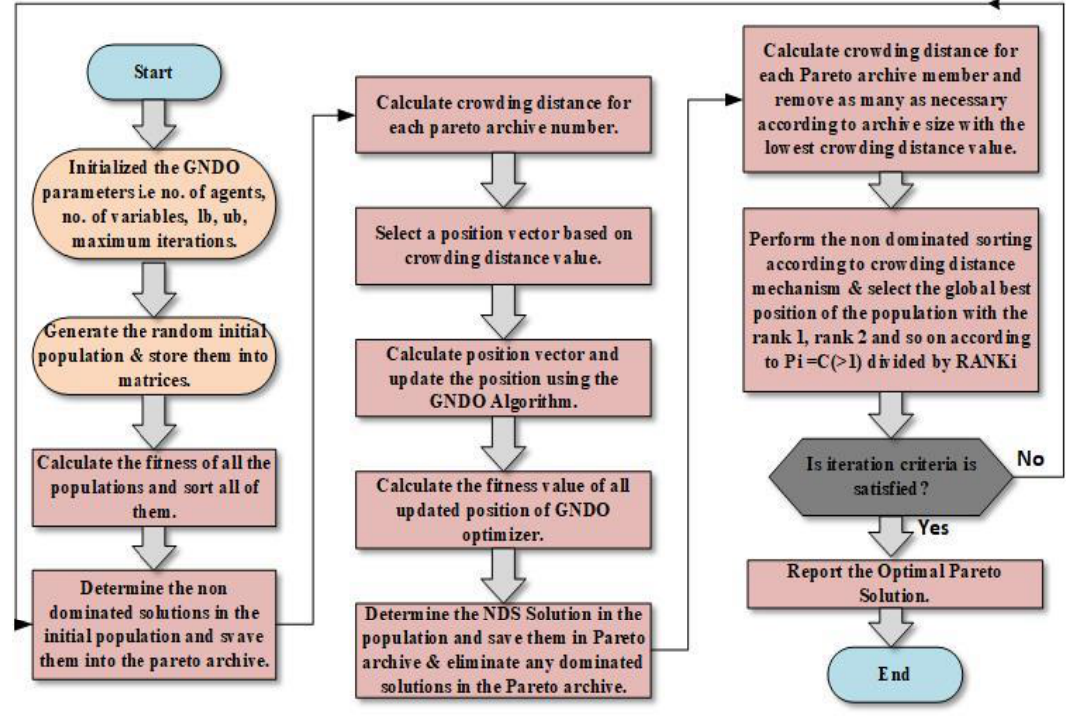
Figure 11. Flowchart of MOGNDO algorithm.